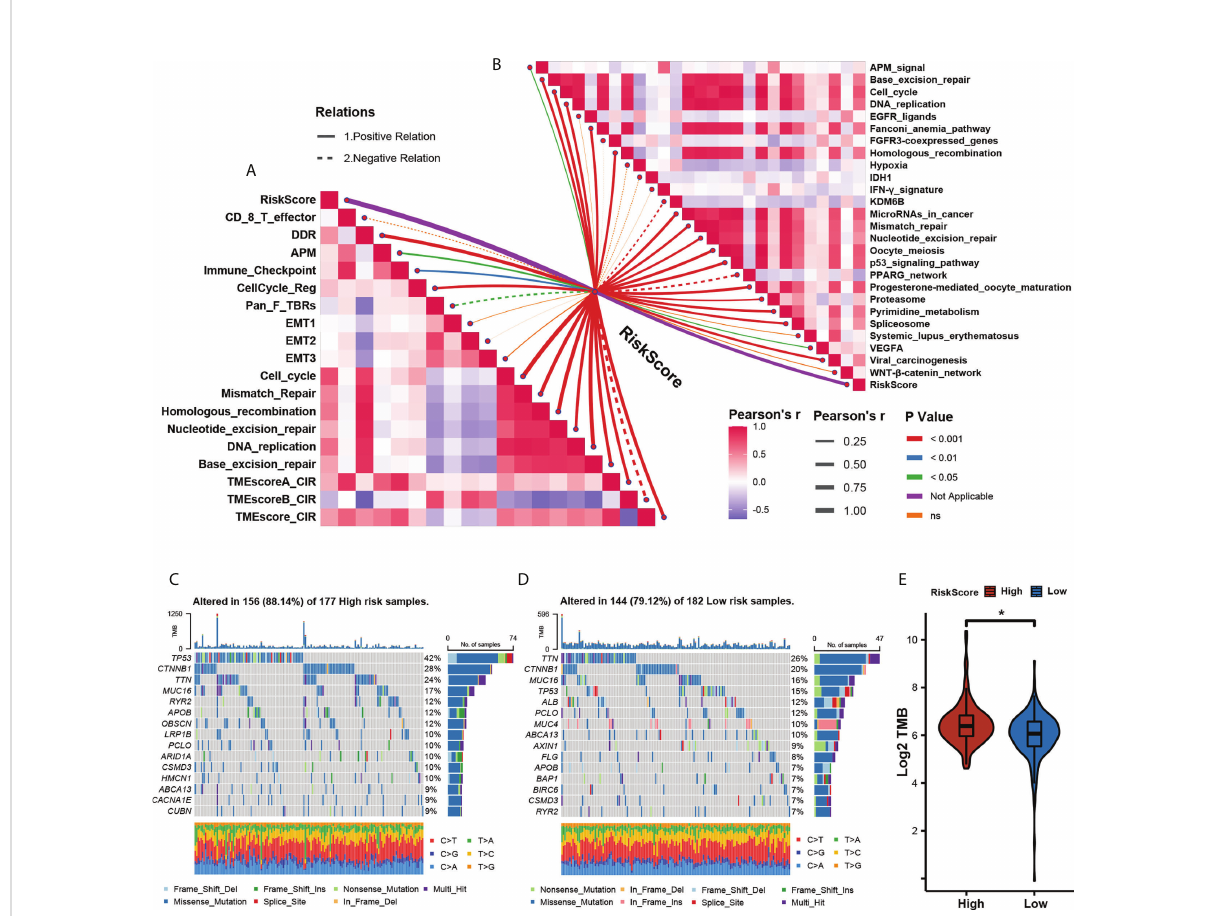
FIGURE 6 Assessing tumor microenvironment characterization with the prognostic. (A) . The correlations between the m5C score and the enrichment scores of TME pathways. (B) The correlations between the m5C score and the enrichment scores of immunotherapy- predicted pathways. (C, D) The mutational landscape between High- (C) and Low- (D) m5C score groups. (E) Relative distribution of tumor mutation load in High- versus Low- m5C score groups. (*